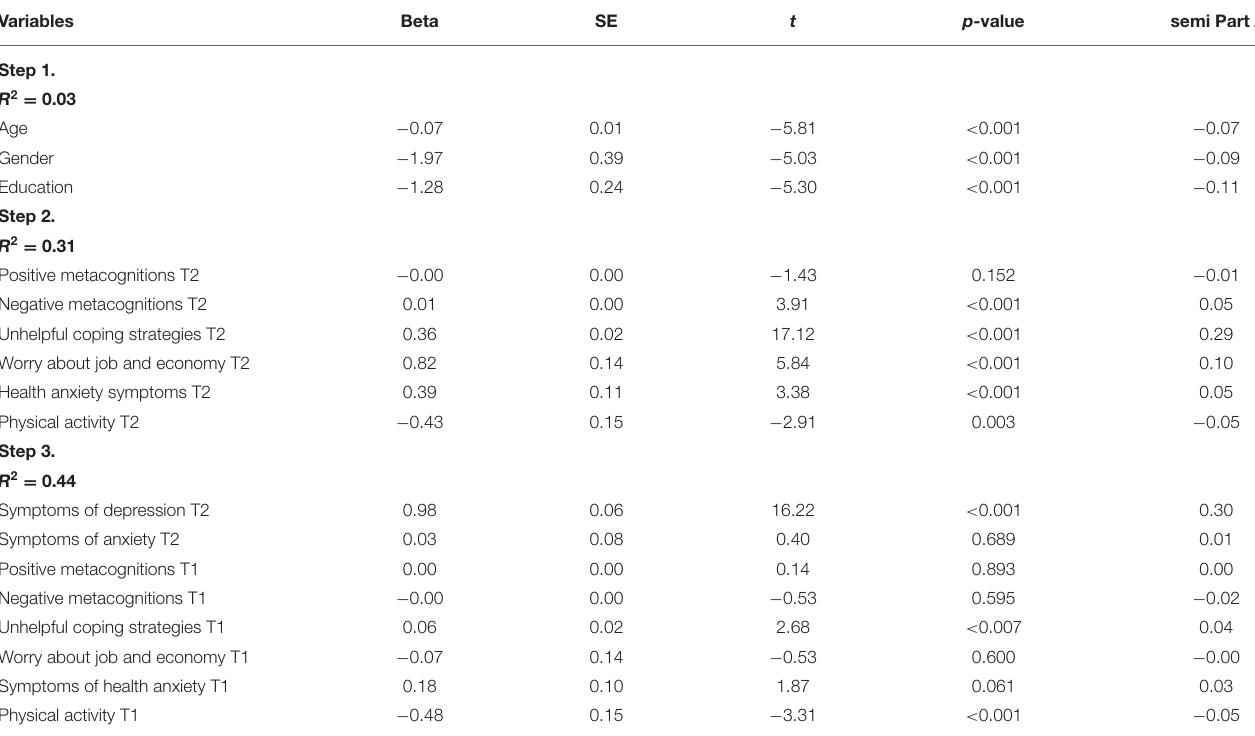
TABLE 3 | Results of multiple regression with Insomnia (BIS) as the dependent variable.